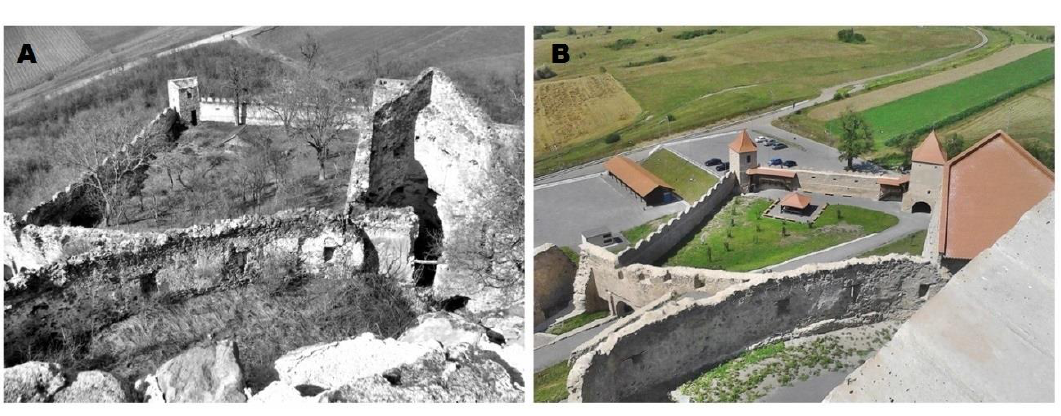
Figure 5: View over The Lower Fortress, A – before and B – after rehabilitation Photos from the author’s personal collection (A: 2002; B: